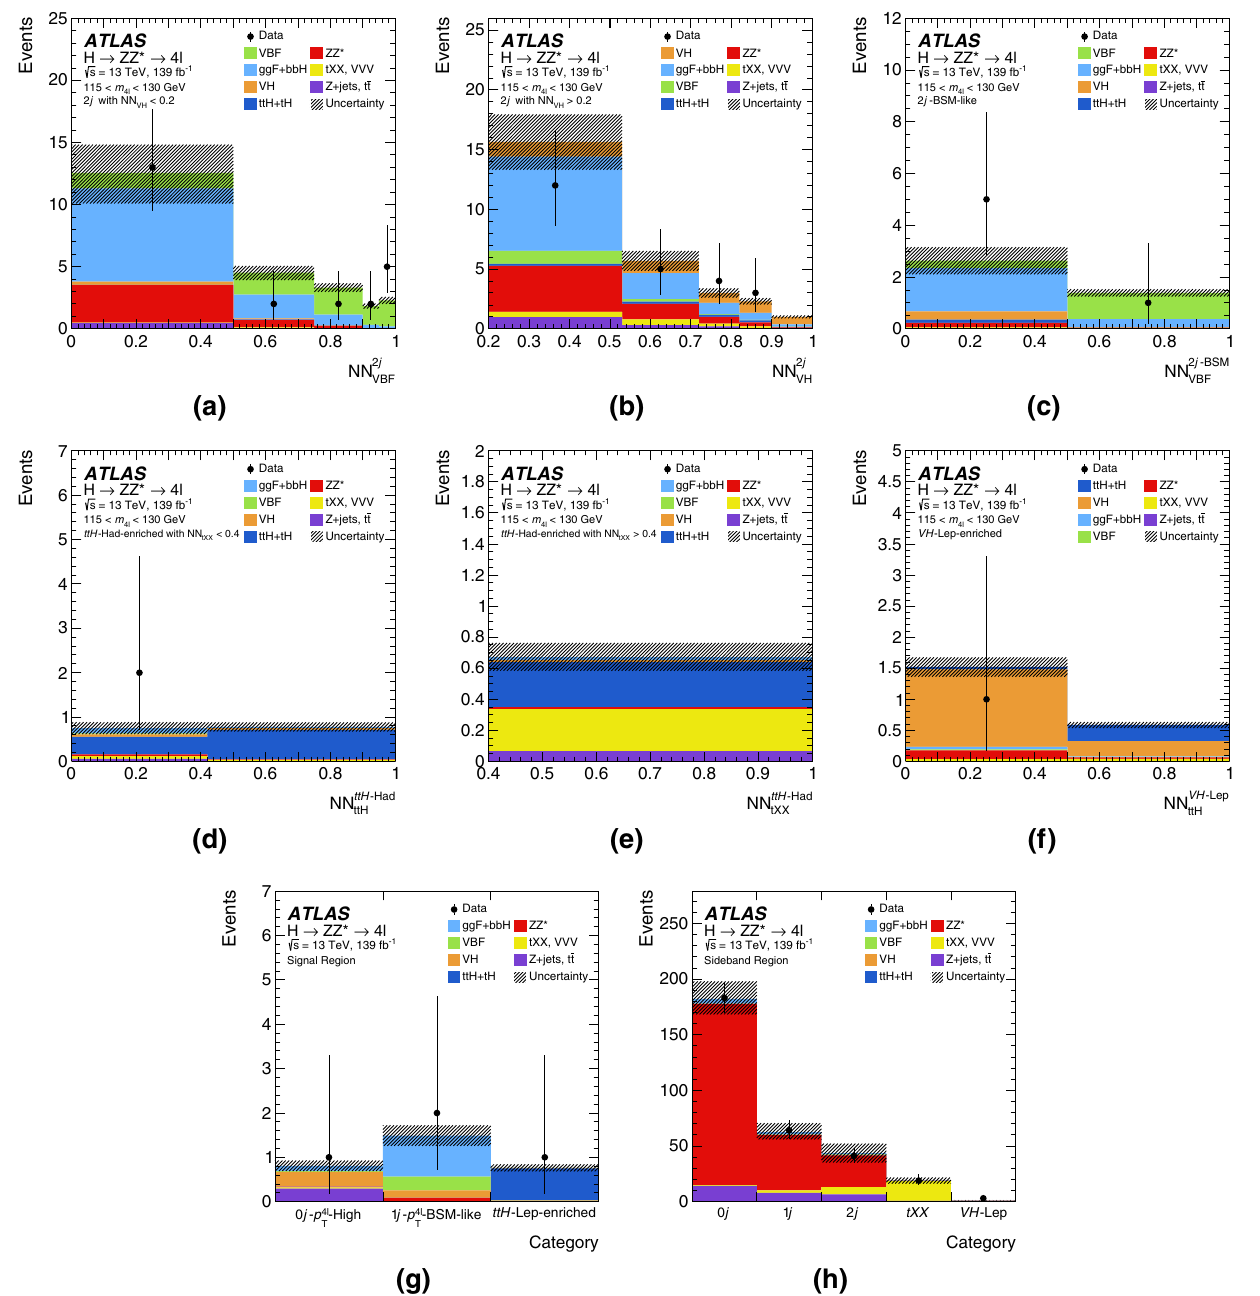
Fig. 8 The observed and expected NN output (post-fit) distributions used to constrain the Z Z ∗ and tX X backgrounds. The SM Higgs boson √ for an integrated luminosity of 139 fb − 1 at signal is assumed to have a mass m H = 125 GeV. The uncertainty in s = 13 TeV in the dif- ferent categories: ( a ) NN VBF in 2 j with NN VH < 0 . 2, ( b ) NN VH in the prediction is shown by the hatched band, calculated as described in Sect. 7. For comparison only, the hatched band includes the theoretical 2 j with NN uncertainties in the SM cross-section for the signal and the background processes. The bin boundaries are chosen to maximise the significance of the targeted signal in each